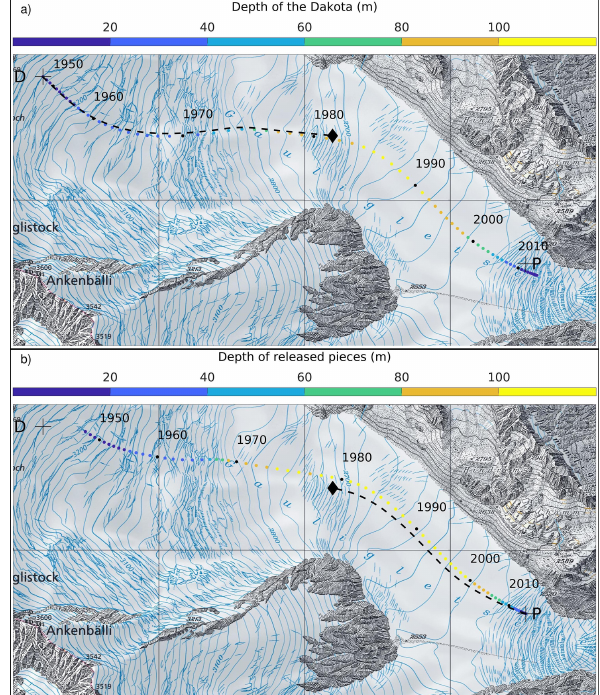
Figure 10. Topographic map of Gauligletscher with 1km grid spac- ing showing the modeled horizontal trajectory of (a) the main body of the Dakota from 1947 to 2019 after integrating the modeled ve- locity field forward in time; and (b) the airplane pieces released from 2018 to 1947 after integrating the modeled velocity field back- ward in time. In both cases, we used the best-guess model run (Fig. 4). The corresponding forward (or backward) trajectory and its end position in 2019 (or 1947) computed by Compagno et al. (2019) is shown with a dashed line and a diamond symbol in panel (a) (or (b) ) for comparison purposes. The location where the Dakota air- plane crash-landed in 1946 and where pieces of the plane emerged in 2018 at the surface are indicated by the letters “D” and “P”, re- spectively. Reproduced by permission of swisstopo